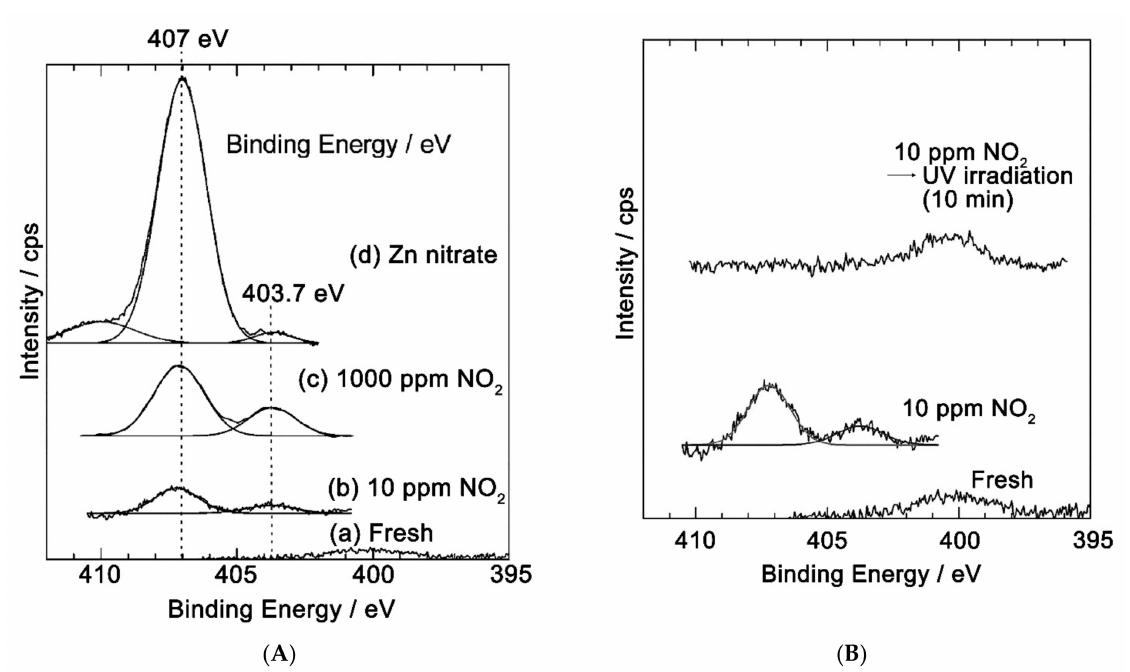
Figure 11. ( A ) XP-spectra on the N1s region for initial ZnO and exposed with 10 and 1000 ppm NO 2 ; ( B ) XP-spectra on the N1s region for ZnO exposed with 10 ppm NO 2 and after UV illumination. Reprinted from